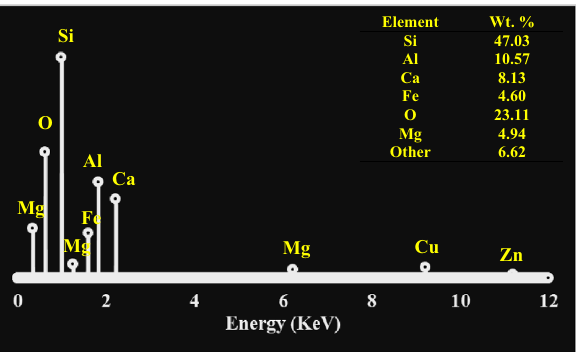
Figure 1. Elemental composition of the coconut shell ash as obtained by energy dispersive spectrometer